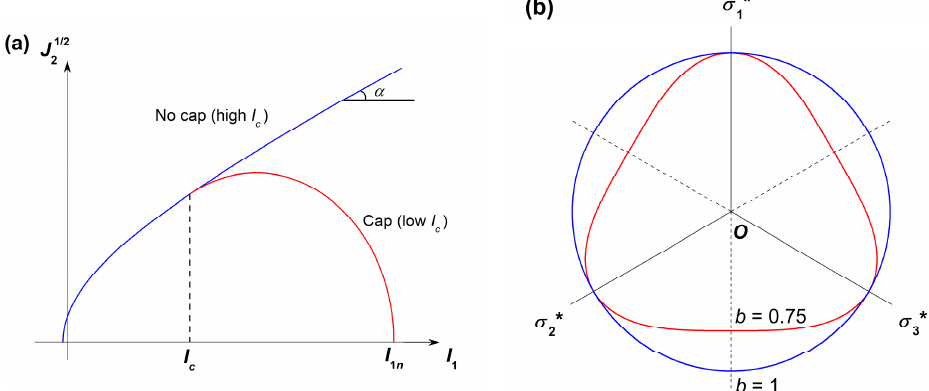
Figure 1. MSDP u failure surface in the ( a ) I 1 – J 21/2 plane and ( b ) π ‐ plane ( σ 1 *, σ 2 *, σ 3 * are the projec ‐ tions of the principal stress axes in the π ‐